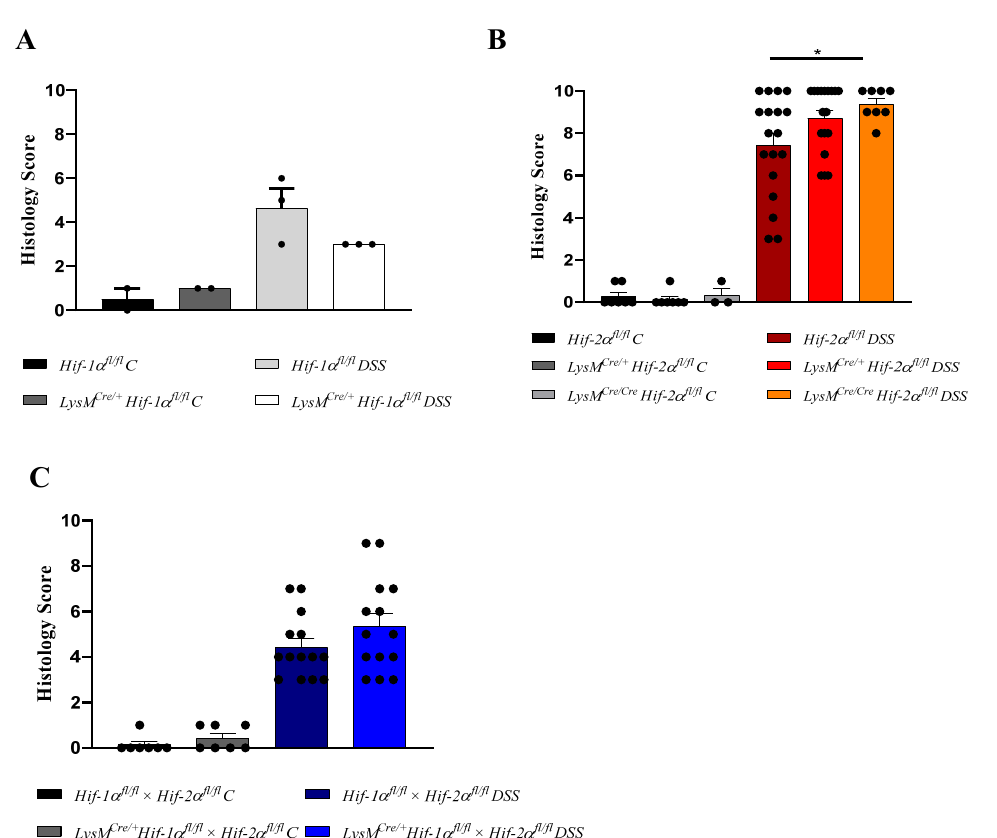
Figure 3. Myeloid knockout of HIF-1 α led to a low colon histology score, while myeloid knockout of HIF-2 α increased it. H&E-stained sections of the colon of Hif-1 α fl / fl , LysM Cre /+ Hif-1 α fl / fl animals ( A ), Hif-2 α fl / fl , LysM Cre / + Hif-2 α fl / fl and LysM Cre / Cre Hif-2 α fl / fl animals ( B ), and Hif-1 α fl / fl × Hif-2 α fl / fl and LysM Cre /+ Hif-1 α fl / fl × Hif-2 α fl / fl animals ( C ) with and without DSS treatment were evaluated by a histology score (for parameters see Table 2). The DSS-treated LysM Cre / Cre Hif-2 α fl / fl animals showed the highest score and DSS-treated LysM Cre /+ Hif-1 α fl / fl animals had the lowest score. Statistical analysis was performed with an unpaired t -test. Mean values ± SEM; A: n (C) = 2, n (DSS) = 3; B: n (C) = 3 ( LysM Cre / Cre Hif-2 α fl / fl ) / 8 ( Hif-2 α fl / fl , LysM Cre / + Hif-2 α fl / fl ), n (DSS) = 8 ( LysM Cre / Cre Hif-2 α fl / fl ) / 18 ( Hif-2 α fl / fl , LysM Cre / + Hif-2 α fl / fl ); and C: n (C) = 7, n (DSS) = 14. Each black dot represents the score of a single animal. *: p <